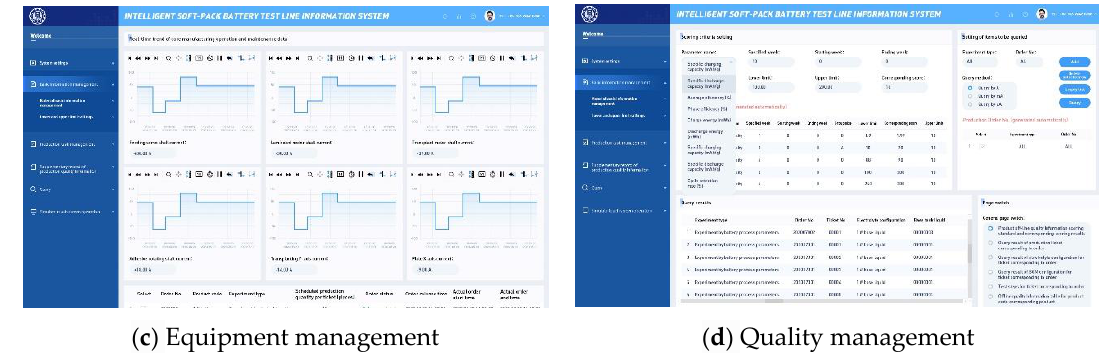
Figure 15. Display of some software interfaces of an intelligent information system.